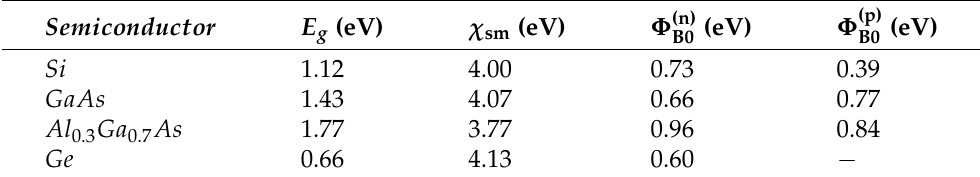
Table 2. Bandgap E g and electron affinity χ sm of various semiconductors together with values of SBH when the Schottky junction is formed, calculated thanks to Equations (15)–(17) by taking into account an initial extrinsic p-doping n 0 = 10 12 cm − 2 of the single-layer graphene (SLG) and the thermal equilibrium contact with the substrate. For the calculations we considered low-doped semiconductors (i.e., N = 10 16 cm − 3